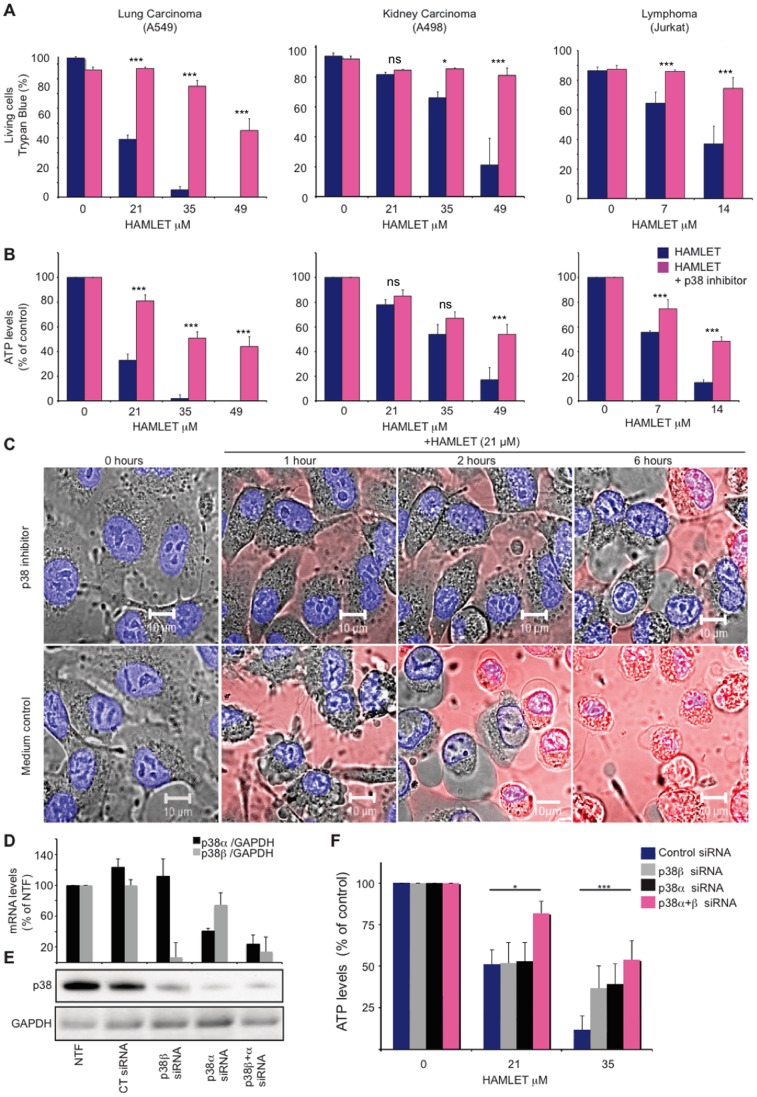
p38 inhibition rescues carcinoma and lymphoma cells from death in response to HAMLET.(A, B) p38 MAPK inhibition (SB202190, 20 µM, 30 minutes pre-incubation) rescued carcinoma (A549 and A498) and T-cell lymphoma (Jurkat) cells from death in response to HAMLET (7–49 µM, 3 h). Viability was quantified by Trypan blue exclusion (A) or as ATP levels (B). Data are means±SEMs for 3 independent experiments. The p38 inhibitor alone had no significant effect on cell death (leftmost bars in each graph). (C) Real-time images of cell morphology after HAMLET exposure, showing that p38 inhibition prevents morphological changes in carcinoma cells (nuclear condensation, rounding up and blebbing). Alexa-Fluor 568-labeled HAMLET is red and the nuclei are blue (Hoechst 33342). (D–E) A549 lung carcinoma cells were transfected using siRNA against p38α and/or p38β or non-targeting siRNA and compared to non-transfected controls (NTF). Relative p38α and p38βmRNA levels are shown (p38/GAPDH, in % of non-transfected cells) as means+SEMs for four independent experiments. Knockdown was also confirmed on the protein level by western blotting against total p38 MAPK (representative blot shown, *p<0.05, ***p<0.001.). GAPDH was used as a loading control. (F) The cytotoxic effect of HAMLET was quantified 48 hours after transfection as a reduction in ATP levels. Data are means+SEM for four independent experiments. *p<0.05, ***p<0.001. For effects of the p38 inhibitor Birb0796, see Figure S6.